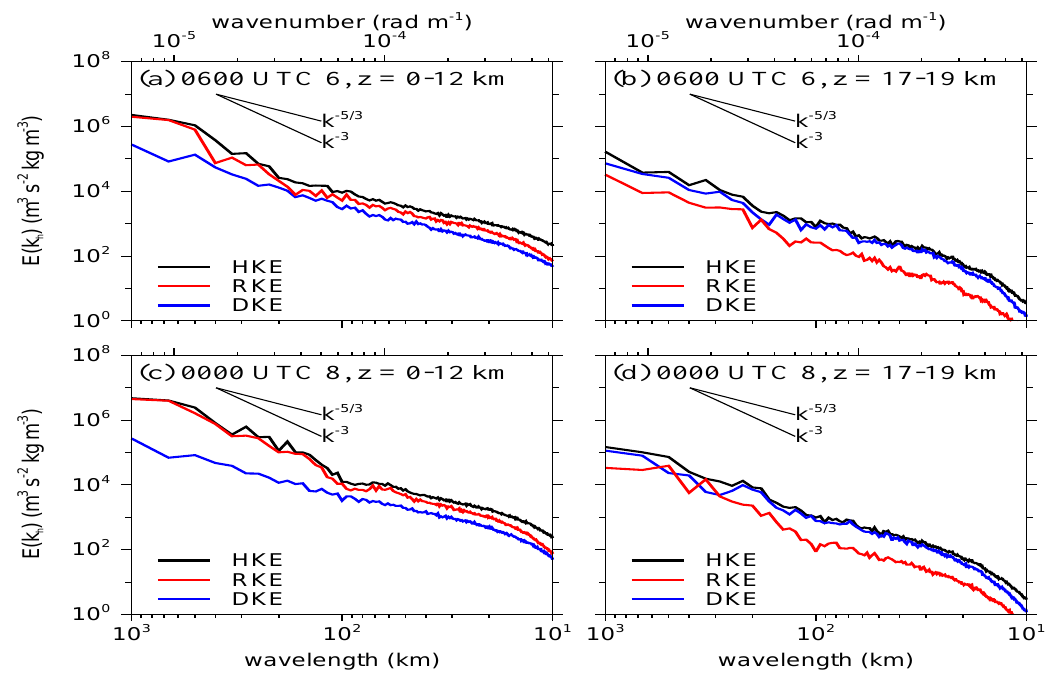
Figure 6. Horizontal wavenumber spectra of HKE (black line), rotational kinetic energy (RKE) (red line), and divergent kinetic energy (DKE) (blue line) averaged vertically over the ( a , c ) troposphere and ( b , d ) lower stratosphere, at ( a , b ) 0600 UTC 6 August and ( c , d ) 0000 UTC 8 August. The reference lines correspond to the − 3 and − 5 / 3